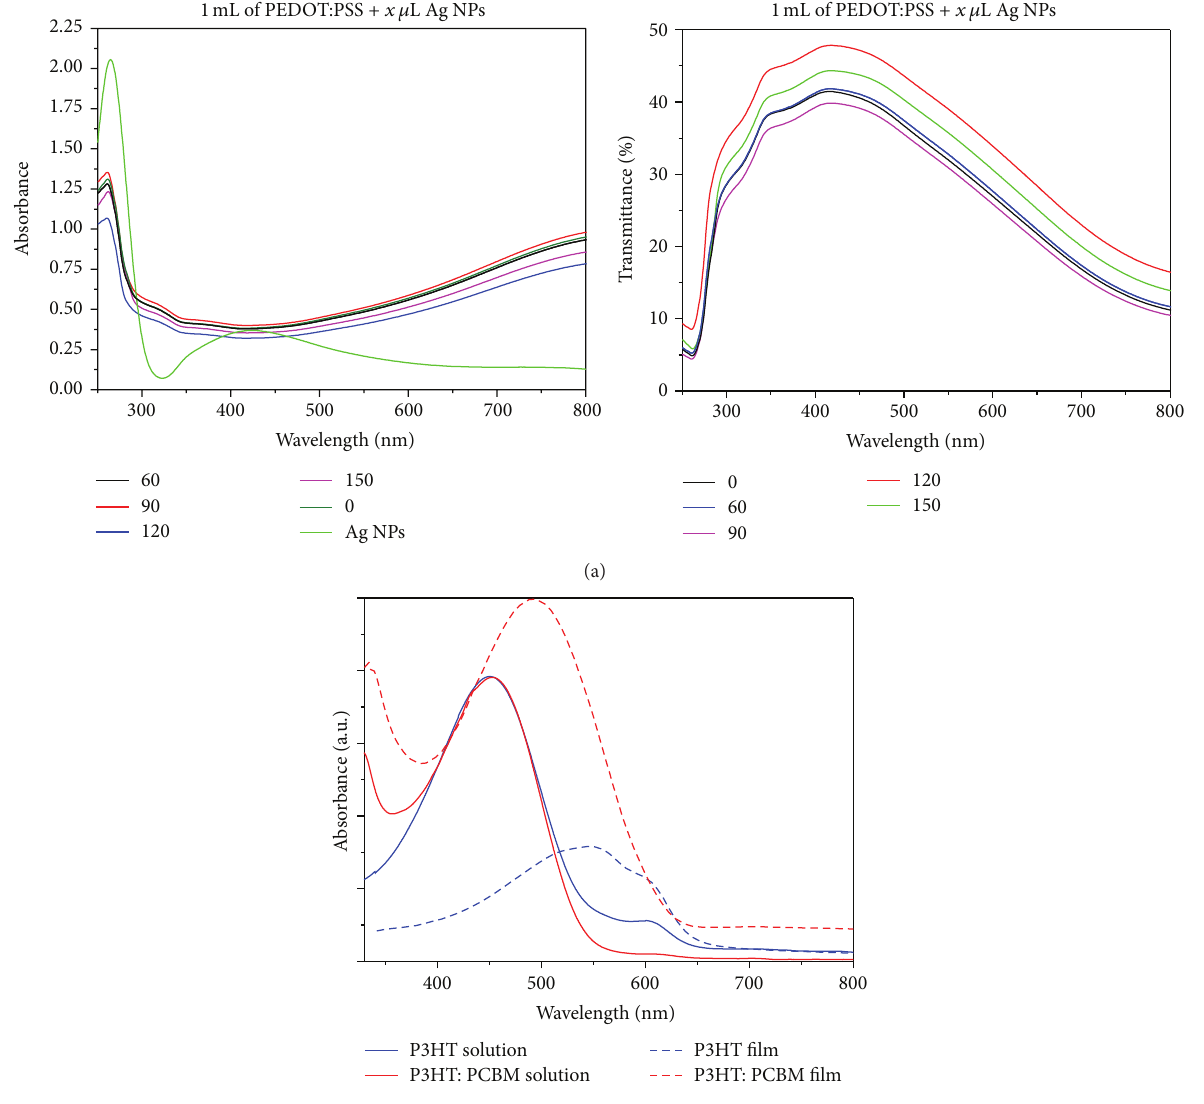
Figure 5: UV-vis spectra of (a) Ag NPs, PEDOT:PSS, and PEDOT:PSS:Ag NPs aqueous solution and (b) P3HT, P3HT:PCBM in film and in chloroform solution.